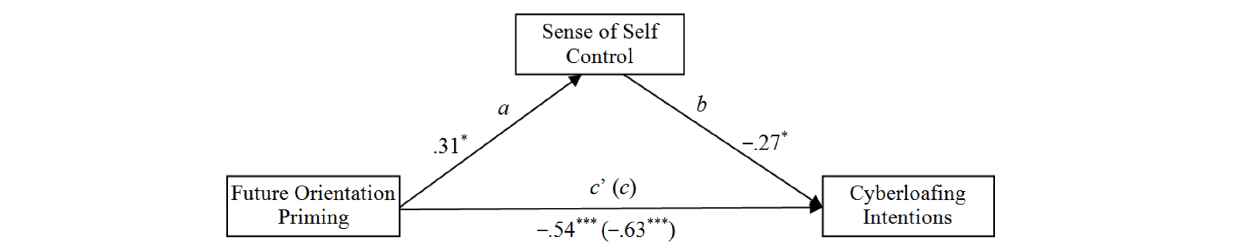
FIGURE 2 | Results from the mediation analyses testing sense of self control as a mediator of the dampening effect of employees’ future orientation on cyberloafing intentions. Total effect (c): Effect = − 0.63, SE = 0.12, p < 0.001, LLCI = − 0.86, ULCI = − 0.39; Direct effect (c’): Effect = − 0.54, SE =